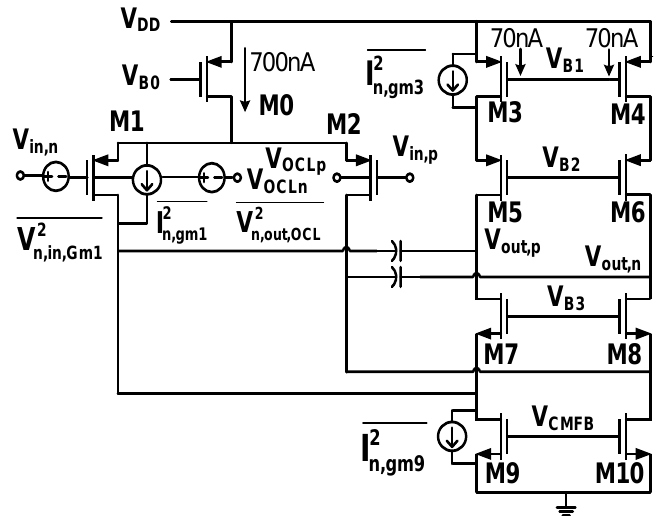
Figure 6. Schematic of the folded cascode op amp using buck control with its noise sources. Table 1. Dimension of MOSFETs in a folded cascode op amp.